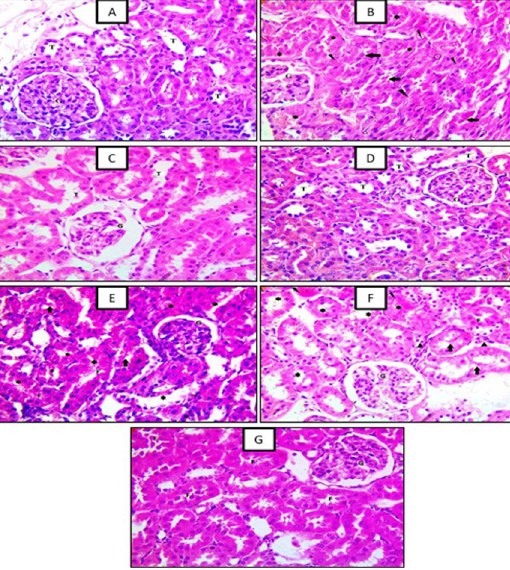
Fig 6. Effect of ellagic acid, cilostazol, and their combination on the structure of the renal cortex. A photomicrograph (H&E stain x400) of renal tissue showing: (A) a normal structure of the renal cortex, tubules (T) and glomeruli (G); control normal, (B) Amikacin (AK), (C) ellagic acid (EA), (D) cilostazol (CTZ), (E) AK + EA, (F) AK + CTZ and (G) AK+EA+CTZ. Ellagic acid (EA) 10 mg/kg, cilostazol (CTZ) 10 mg/kg and their combination were administered one hour before intramuscular injection of amikacin 400 mg/kg for seven